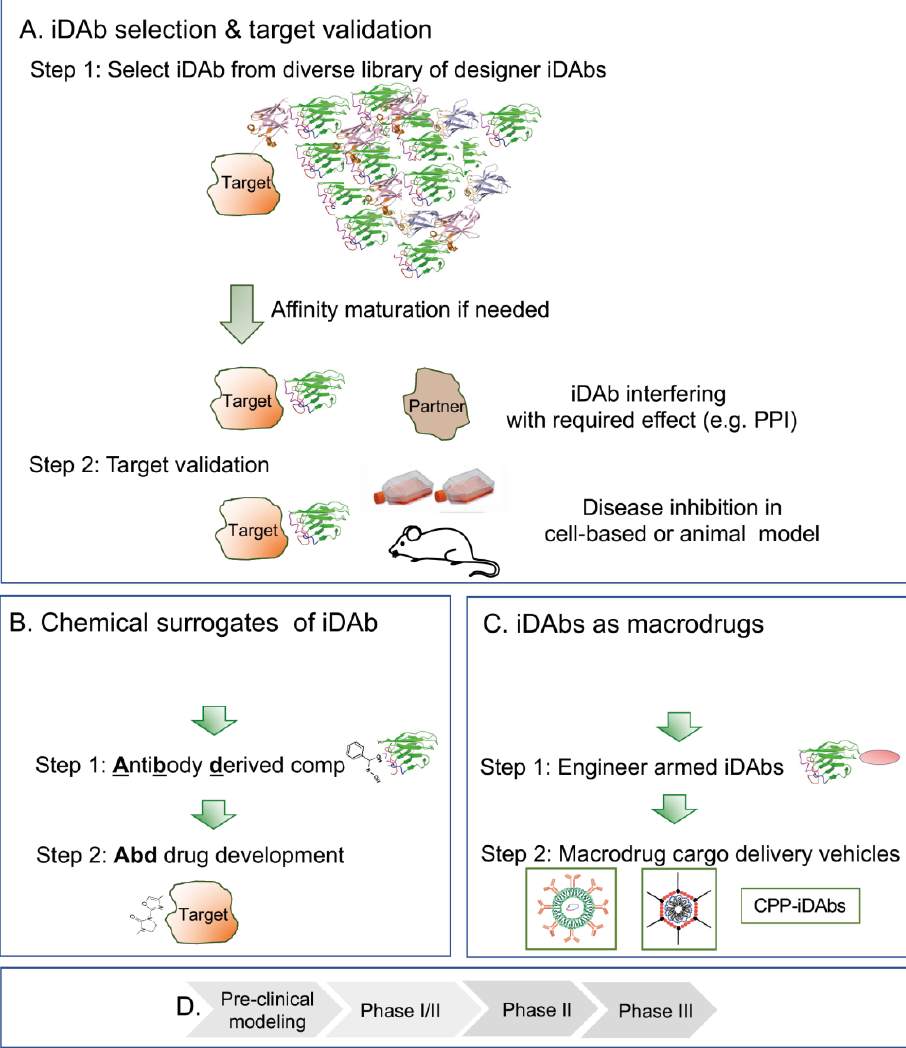
Figure 3. Application of intracellular antibodies for discovery research, target validation and novel therapeutics. Intracellular antibodies are tools for disease target validation (panel ( A , B )) and pre- cursors that can be used in chemical library screens for small-molecule drug development (panel ( C , D )) or as drugs per se (herein macrodrugs). Panel ( A ): for target validation step 1, iDAbs that bind to the selected target protein are obtained via screening a library of diverse iDAbs, followed by identification of a suitable iDAb that has the property required (as shown in panel ( A ), line 3,